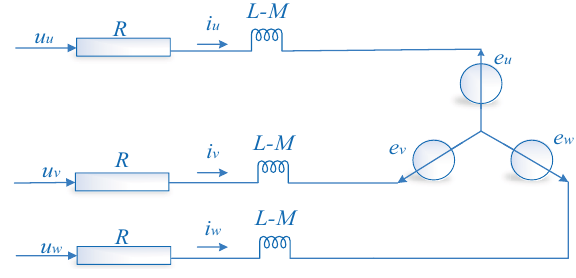
Figure 1. Equivalent circuit of BLDCM.